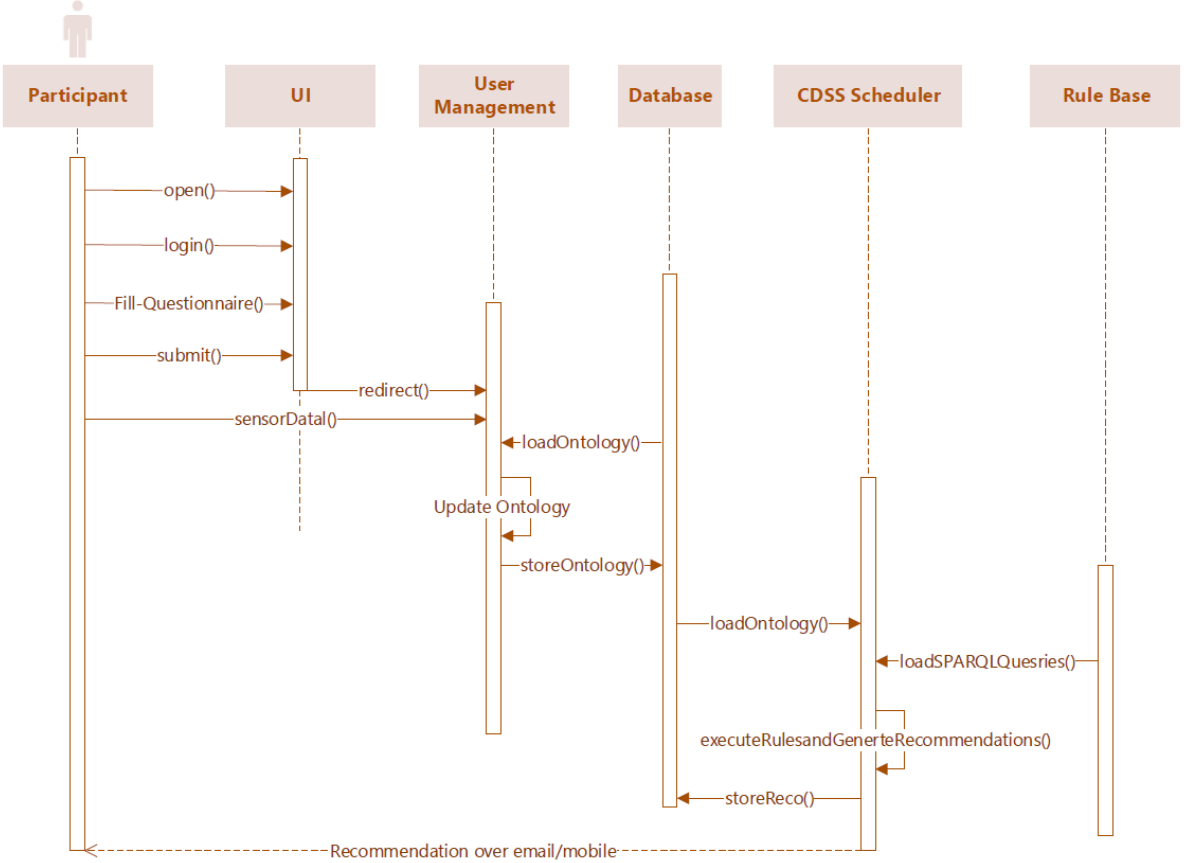
Figure 17. UML sequence diagram for recommendation generation and